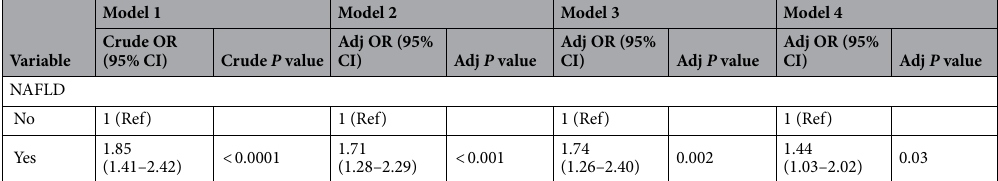
Table 3. Association between NAFLD and PN in multivariate logistic regression model. NAFLD non- alcoholic fatty liver disease, PN peripheral neuropathy, BMI body mass index, PIR poverty income ratio, PA physical activity, OR odds ratio, CI confidence interval, Ref reference. Model 1: crude model. Model 2: adjusted for age, gender, ethnicity. Model 3: adjusted for Model2 plus education, smoking status, alcohol consumption, PA, PIR, Hypertension and Hyperlipidemia. Model 4: adjusted for Model3 plus Diabetes, BMI.